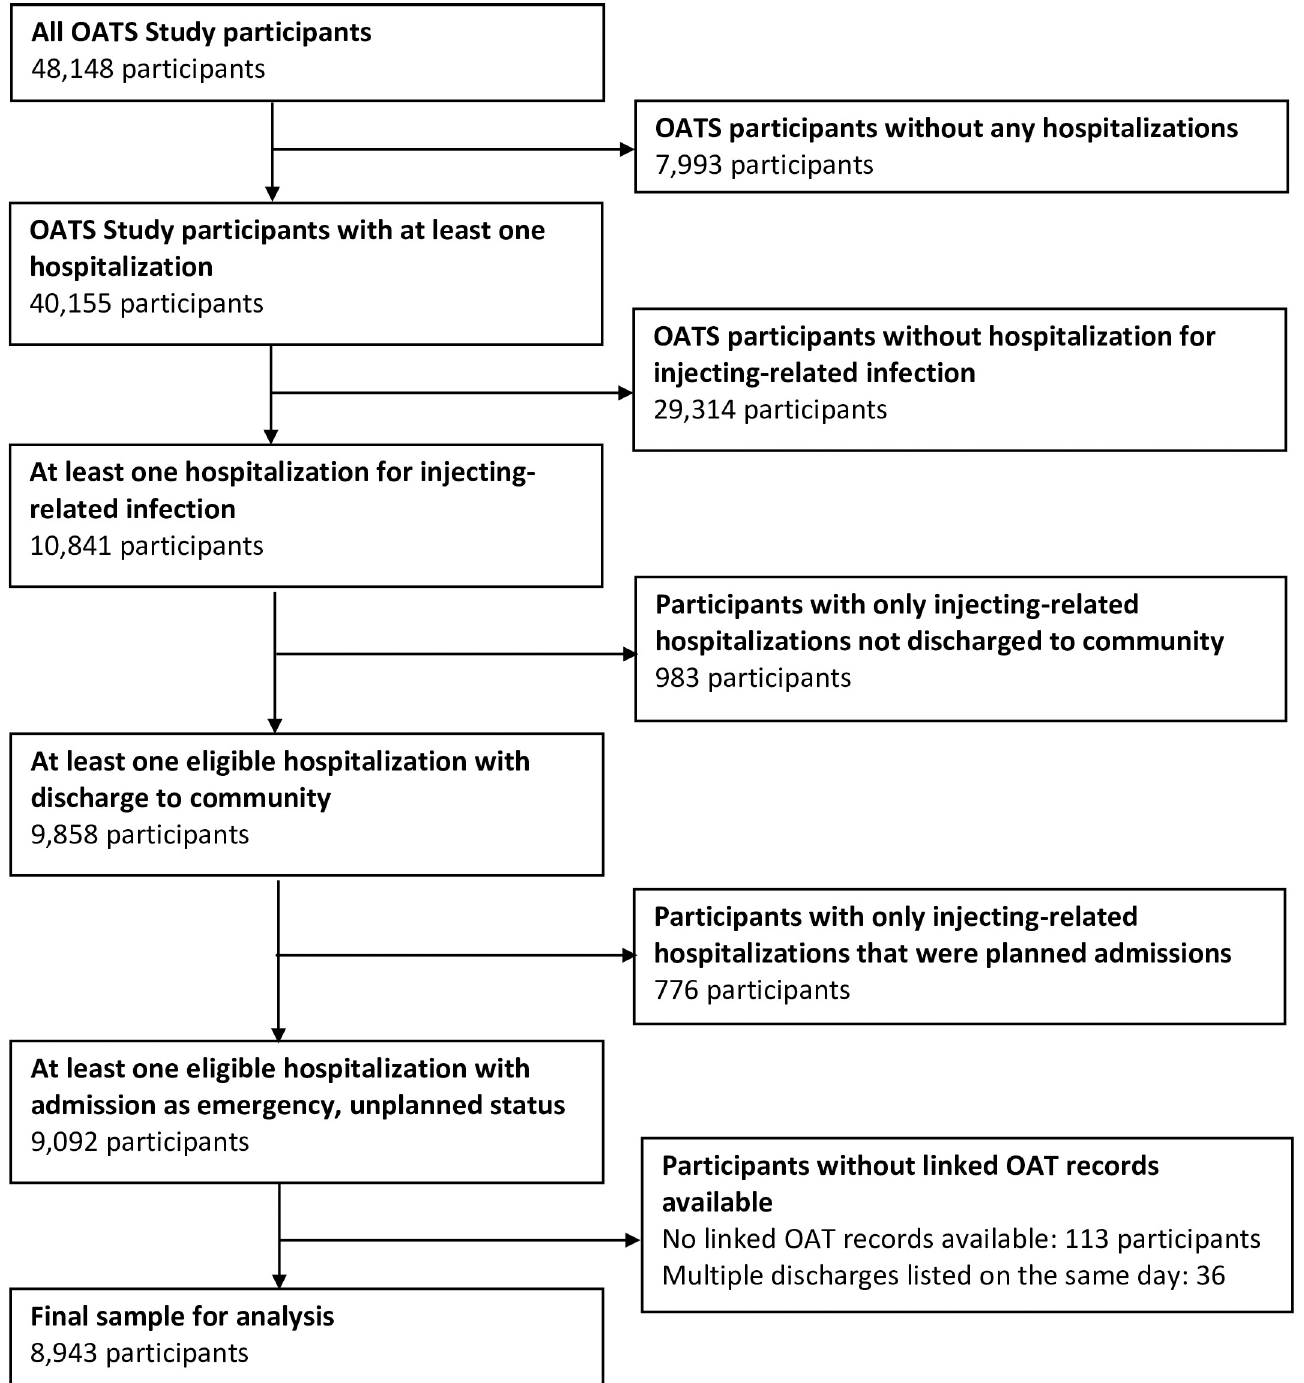
Fig 1. Study flow diagram. OAT, opioid agonist treatment; OATS, Opioid Agonist Treatment Safety.